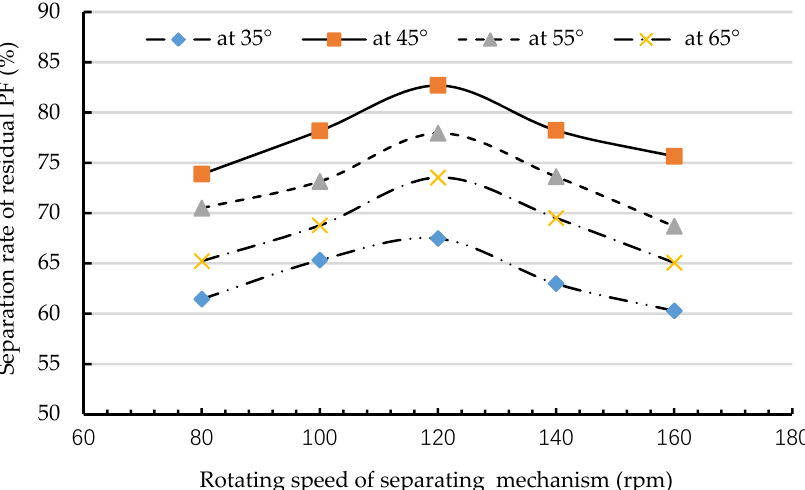
Figure 7. Effect of the separating device’s rotational speed (rpm) on the separation rate of residual PF (%) at different inclination angles between the separating device and the horizontal plane (°).